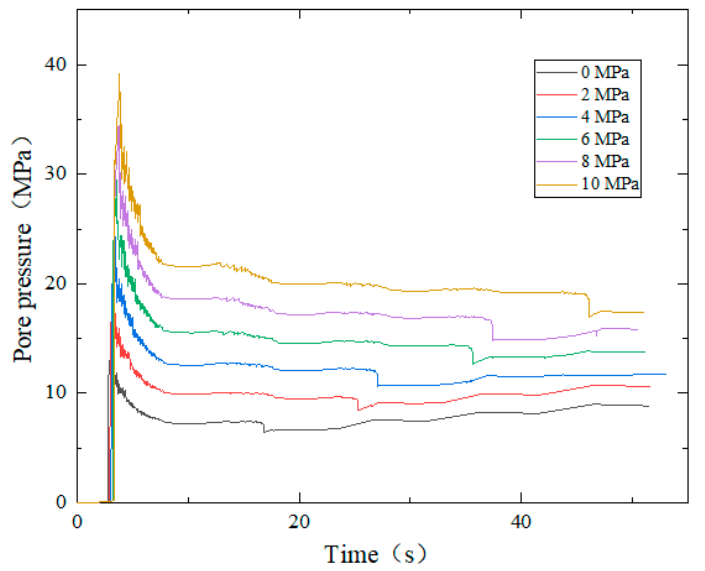
Figure 6. Relationship diagram of pore pressure changes under different confining pressures.